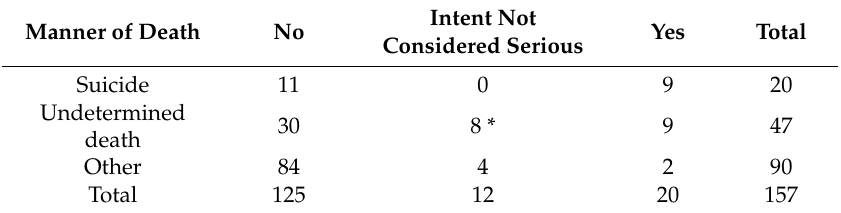
Table 3. Suicidal outcome by manner of death according to staff’s judgement.